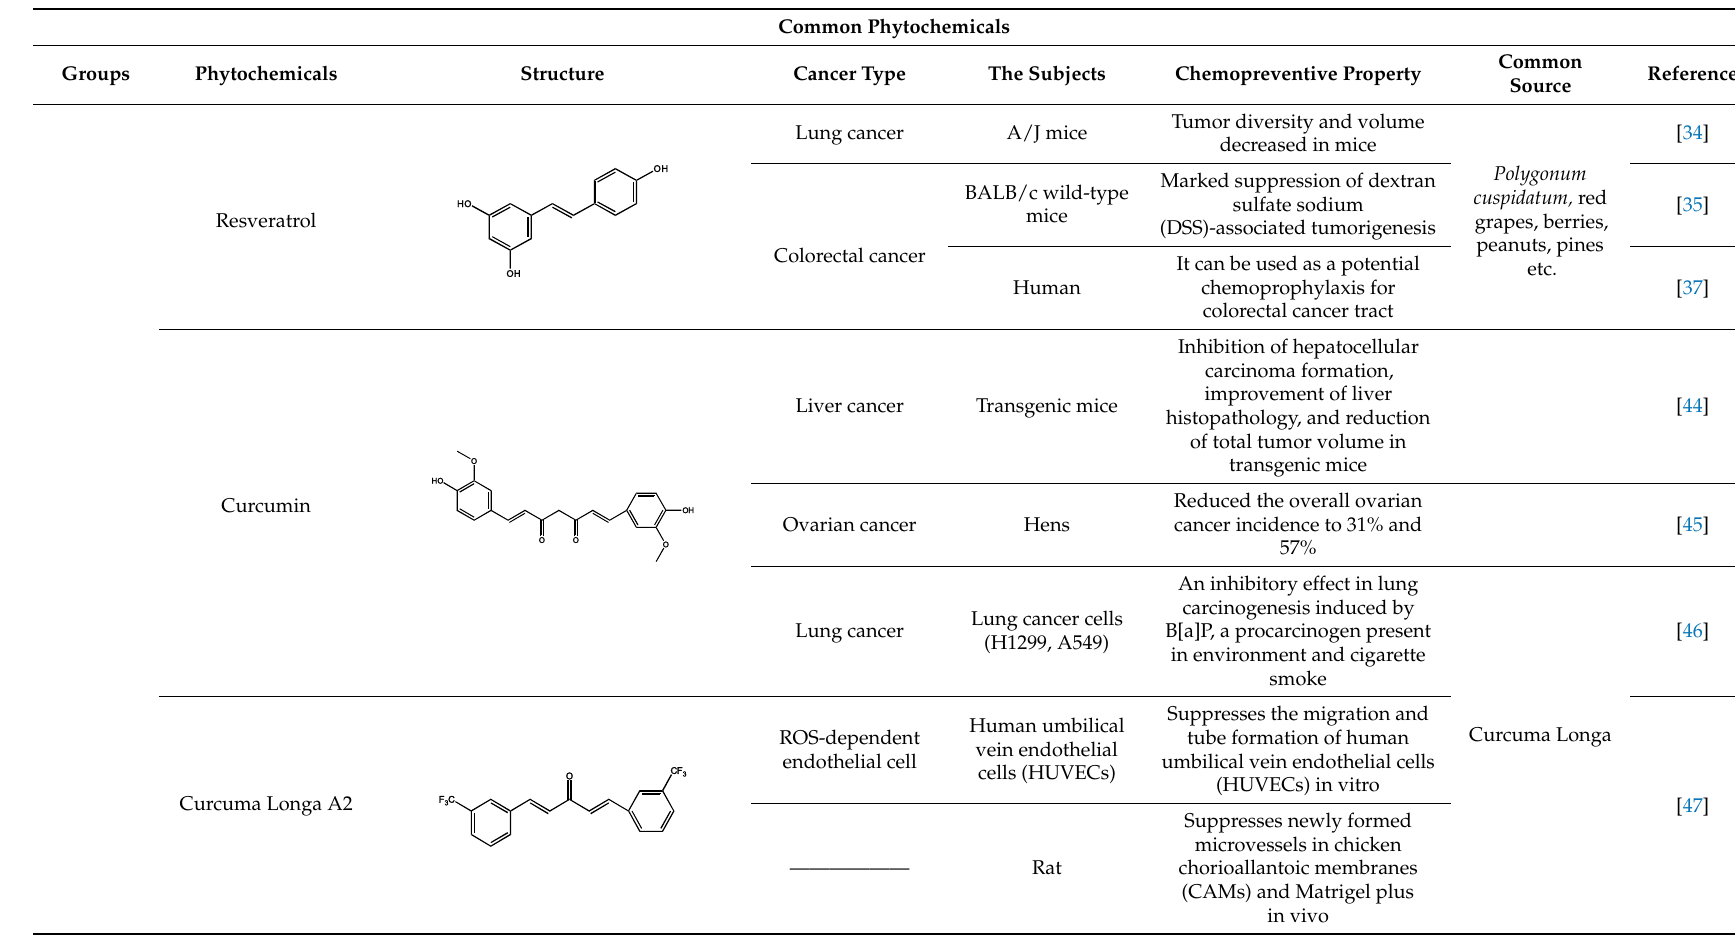
Quercetin Flavo- noids Lutein HO